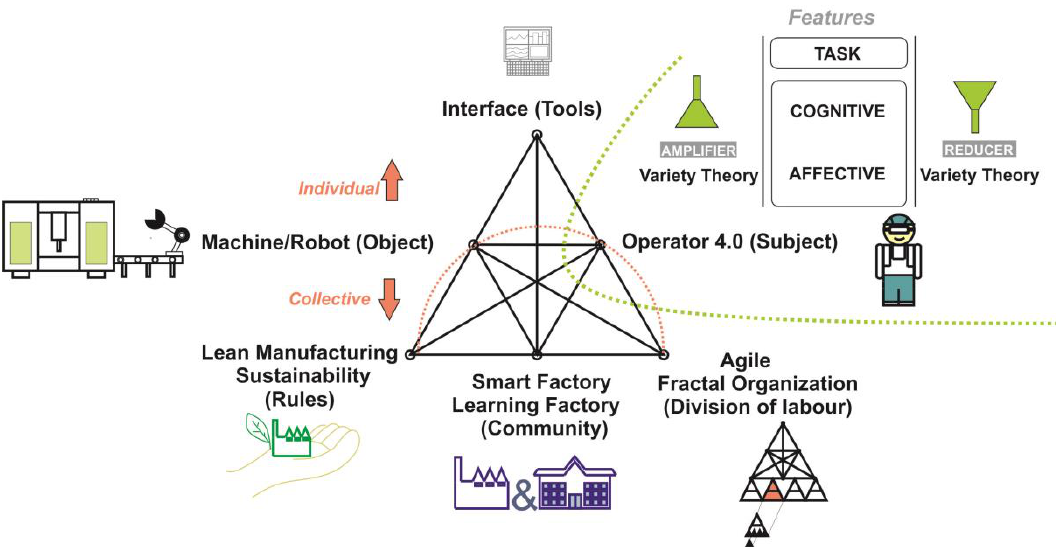
Figure 5. Activity theory and Law of requisite variety to model characteristics of Operator 4.0.